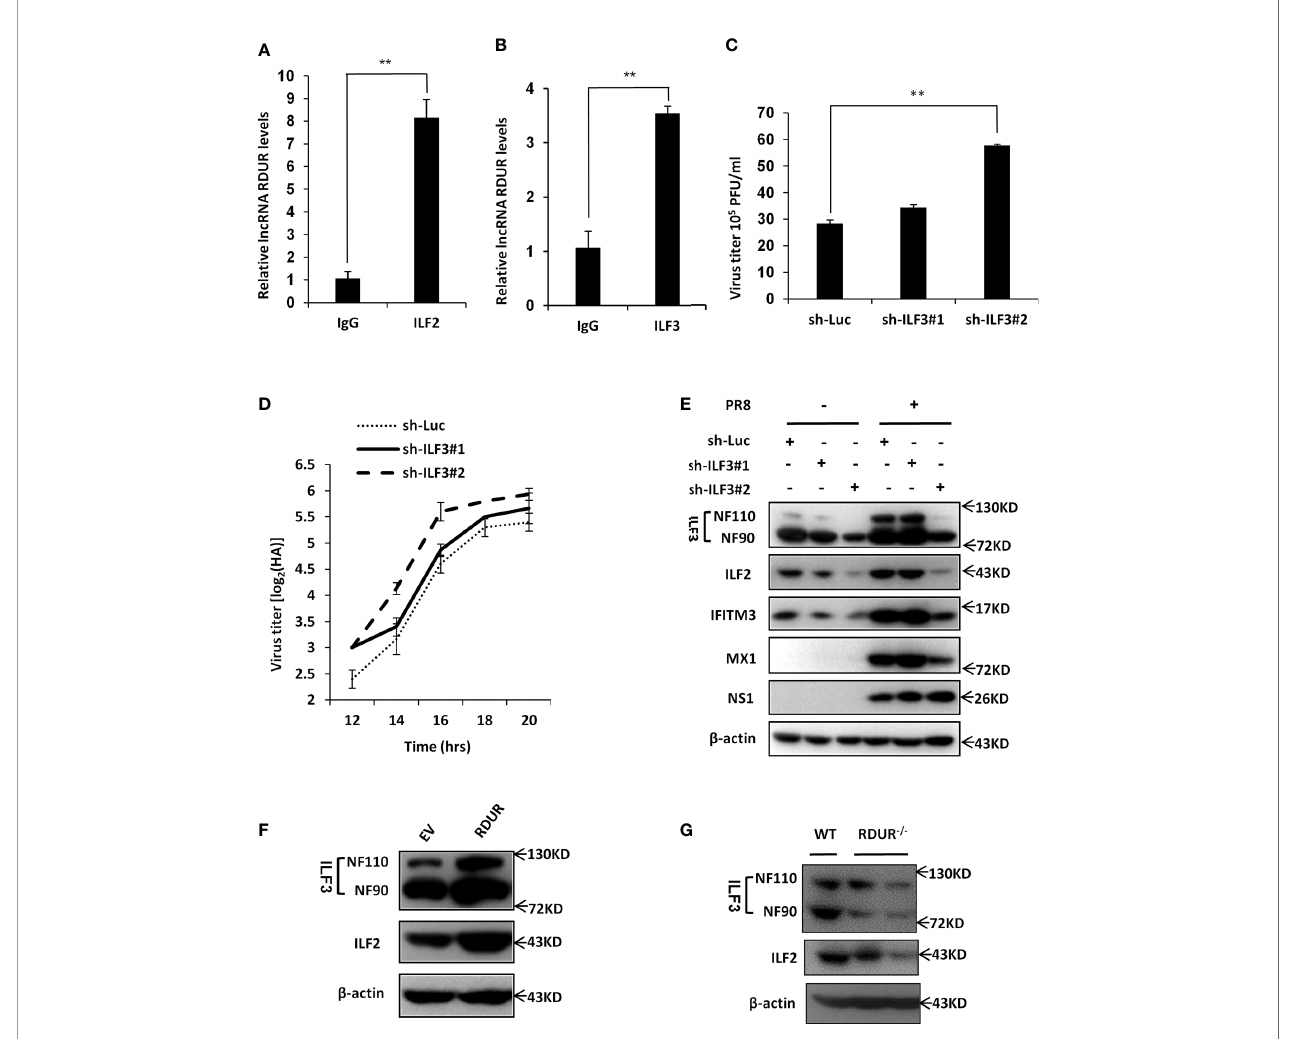
FIGURE 8 | RDUR interacts with ILF2 and ILF3 RNA binding proteins. (A, B) RIP assay was performed using ILF2-speci fi c antibody (A) or ILF3-speci fi c antibody (B) or normal IgG control and quantitative real-time PCR was performed to detect RDUR in A549 cells infected with IAV for 16 h. (C) ILF3 knockdown A549 cells were infected with IAV for 14 h and the virus titers were measured by plaque assay. Plotted are the average levels from three independent experiments. Data are shown as means ± SD, ** P < 0.01. (D) ILF3 knockdown A549 cell lines were infected with PR8 and the virus titers in the supernatants were measured by HA assay at indicated time points. Shown are average results from three independent experiments. Data are shown as means ± SD. (E) A549 cell lines stably expressing speci fi c shRNAs targeting ILF3 and luciferase (control) were infected with or without IAV and harvested at 14 hpi., followed by Western blotting with the indicated antibodies. (F) A549 cells overexpressing RDUR were lysed and Western blotting was performed to detect indicated protein levels. (G) The ILF2 and ILF3 level in the lungs of WT and mRDUR knockout mice were detected by Western